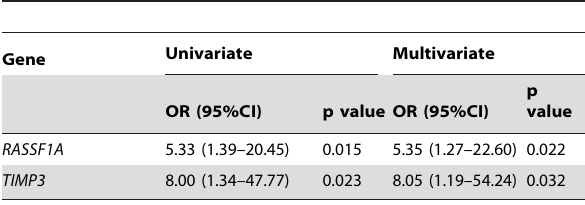
Table 3. Univariate and multivariate logistic regression analysis of RASSF1A and TIMP3 genes.